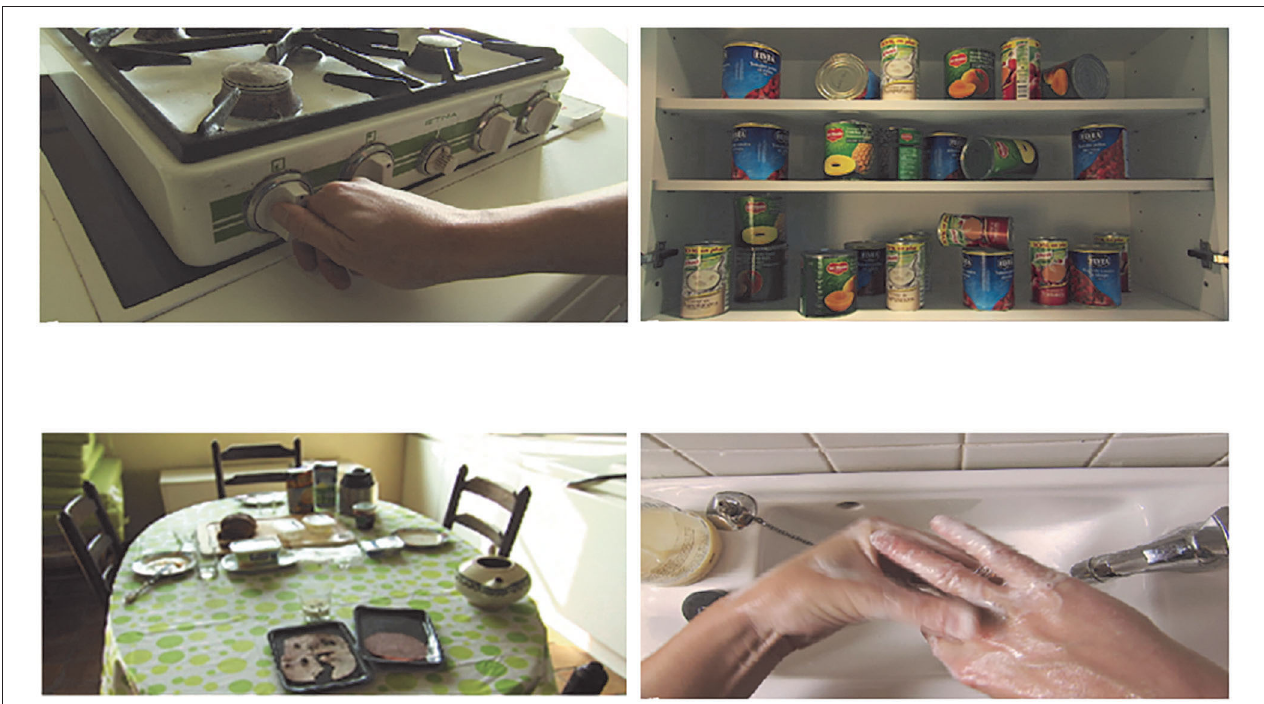
FIGURE 1 | (A) 3D-map of house indicating OCD-related items (figure reprinted with permission from Cyberpsychology, behavior & social networking, publisher: Mary Ann Liebert, Inc., New Rochelle, NY) 1, locking gate start; 2, locking front door start; 3, switching off television; 4, extinguishing candle; 5, organizing pencils; 6, closing window; 7, cleaning breakfast table; 8, putting off gas; 9, organizing cans; 10, cleaning sink; 11, hand washing after toilet; 12, switching off flat iron; 13, organizing hazardous substances; 14, locking front door end; and 15, locking gate end. (B) Screenshots from the VR game (figure reprinted with permission from Cyberpsychology, behavior & social networking, publisher: Mary Ann Liebert, Inc., New Rochelle, NY).